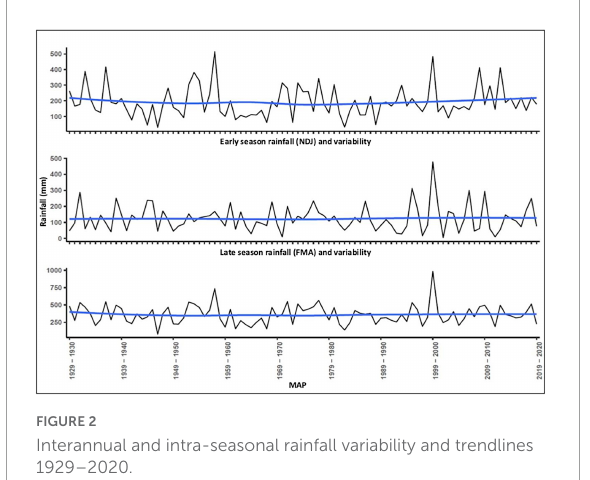
FIGURE2 Interannual and intra-seasonal rainfall variability and trendlines